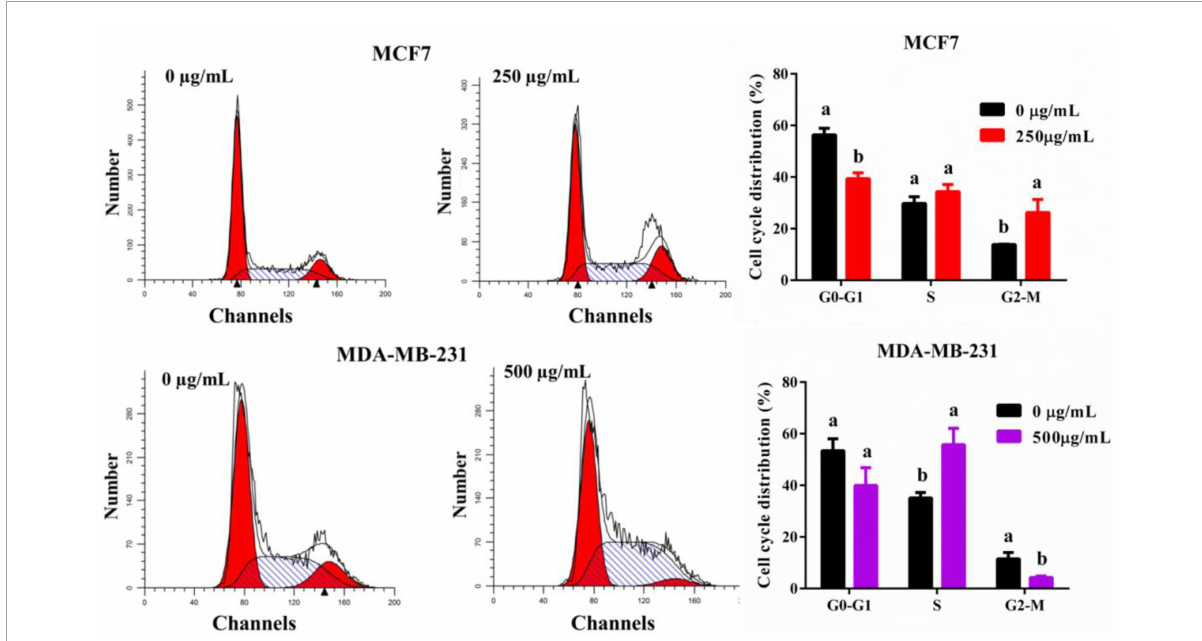
FIGURE6 TPVVVPPFL elicited cell arrest of mammary carcinoma cells. MCF7 cells were incubated with TPVVVPPFL for 48 h at the concentration of 250 ◦ µ g/mL. MDA-MB-231 cells were incubated with TPVVVPPFL for 48 h at the concentration of 500 ◦ µ g/mL. The cell cycle distributions